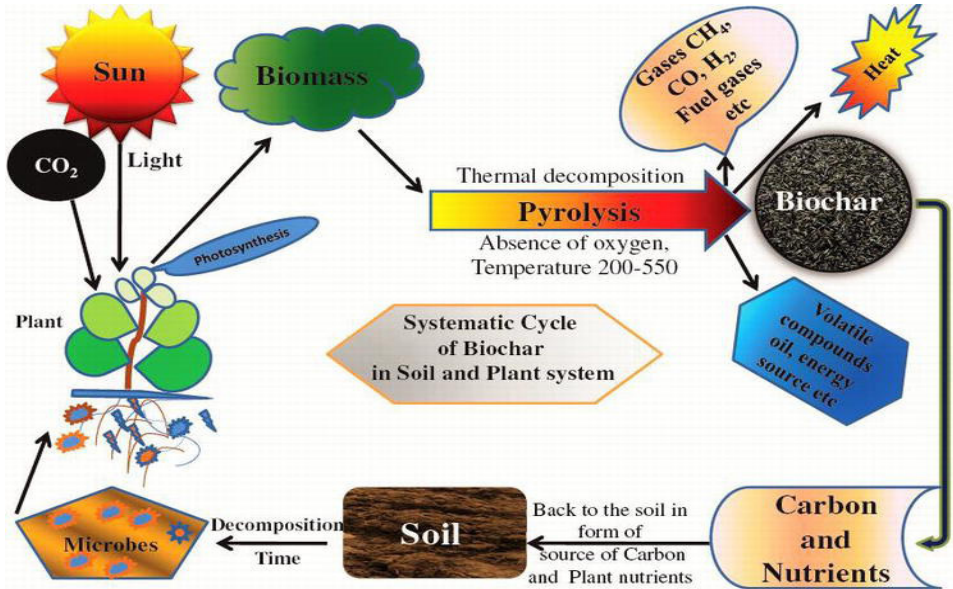
Figure 2. Systemic potential mechanism of biochar in soil and plant system (image collected from Jatav et al. [67]).